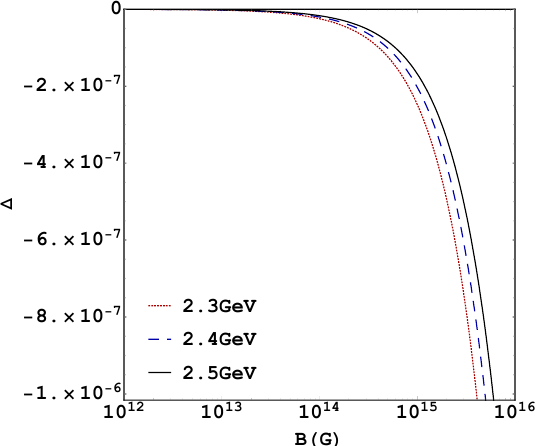
Figure 6. (Color online) Neutron-system polarization versus the magnetic field at zero temperature for three baryonic chemical potentials with values µ = 2.3,2.4,2.5 GeV.